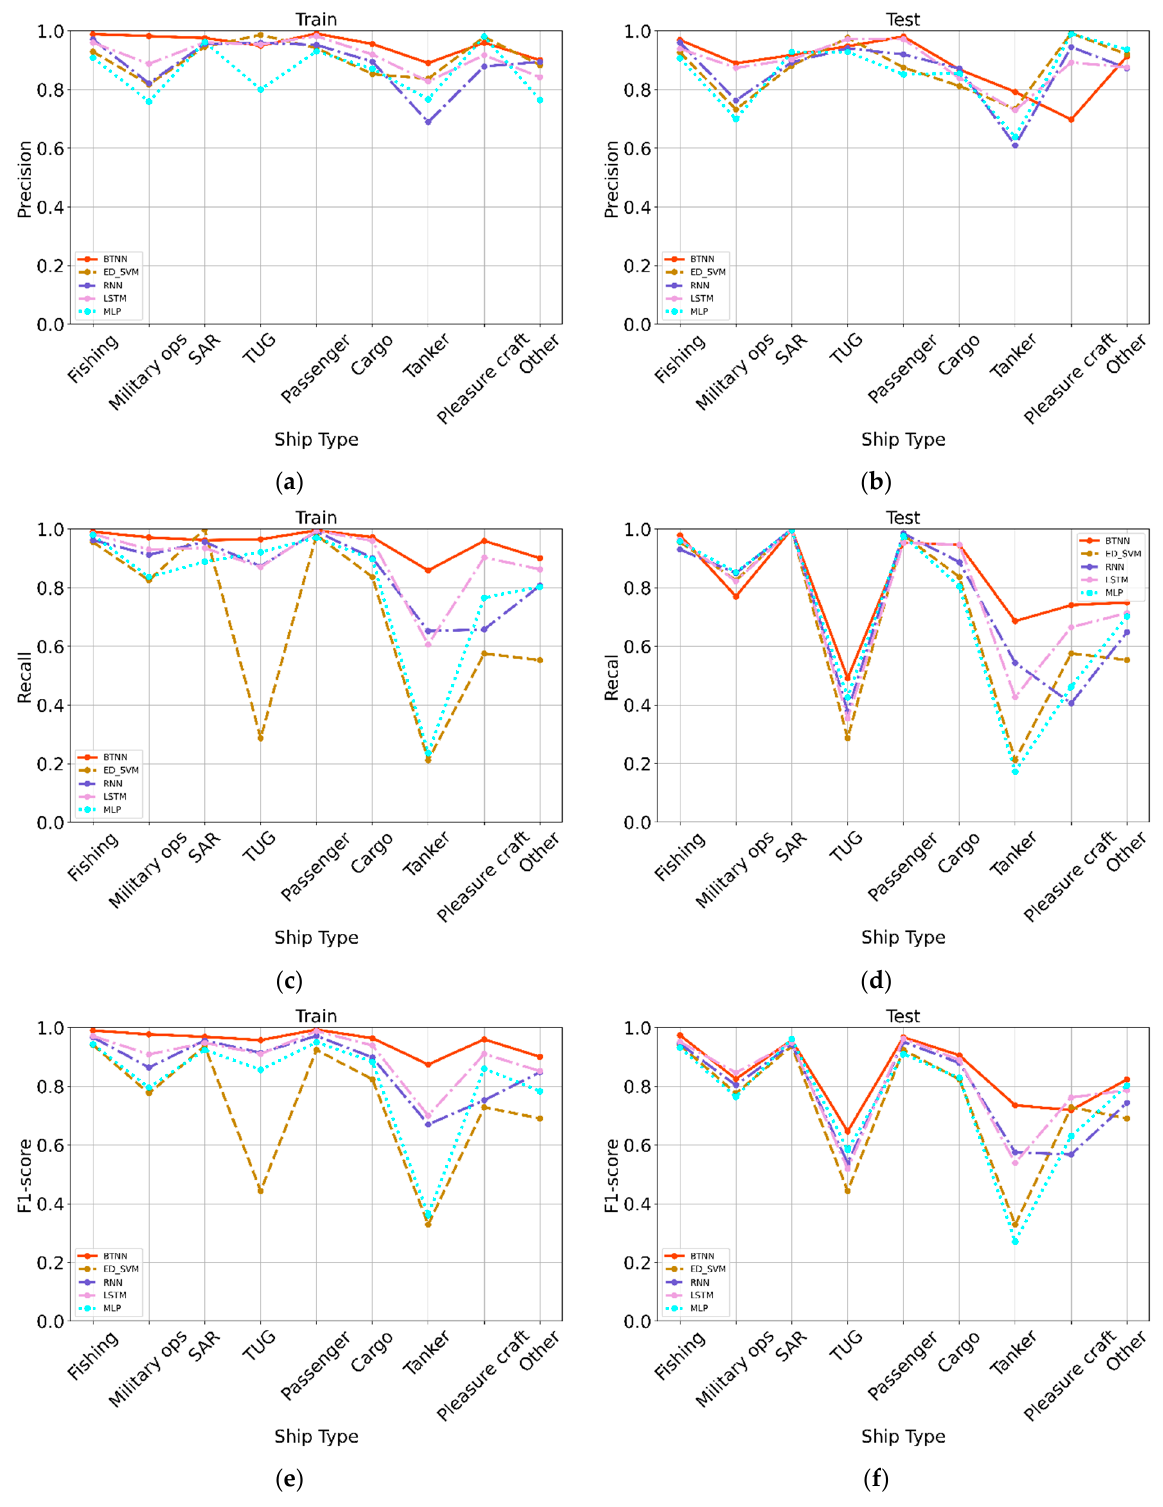
Figure 5. Comparison of Precision, Recall, and F1-score values of different experimental schemes. ( a ) Precision of every target type on training dataset, ( b ) Precision of every target type on test dataset, ( c ) Recall of every target type on training dataset, ( d ) Recall of every target type on test dataset, ( e ) F1-score of every target type on training dataset and ( f ) F1-score of every target type on test dataset.